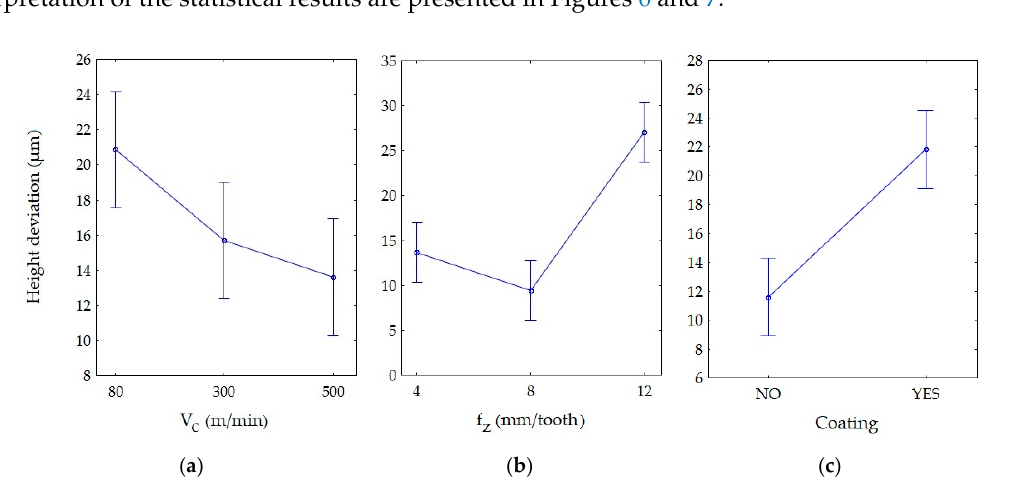
( b ) Figure 7. Interaction on height deviation using: ( a ) non-coated tool and ( b ) TiAlN-coated tool. The vertical bar of one group (V c = 80 m/min, f z = 0.12 mm/tooth, coating: YES) did not overlap with the vertical bars of other groups. Furthermore, there were interactions between the four groups of factors (Figure 7).